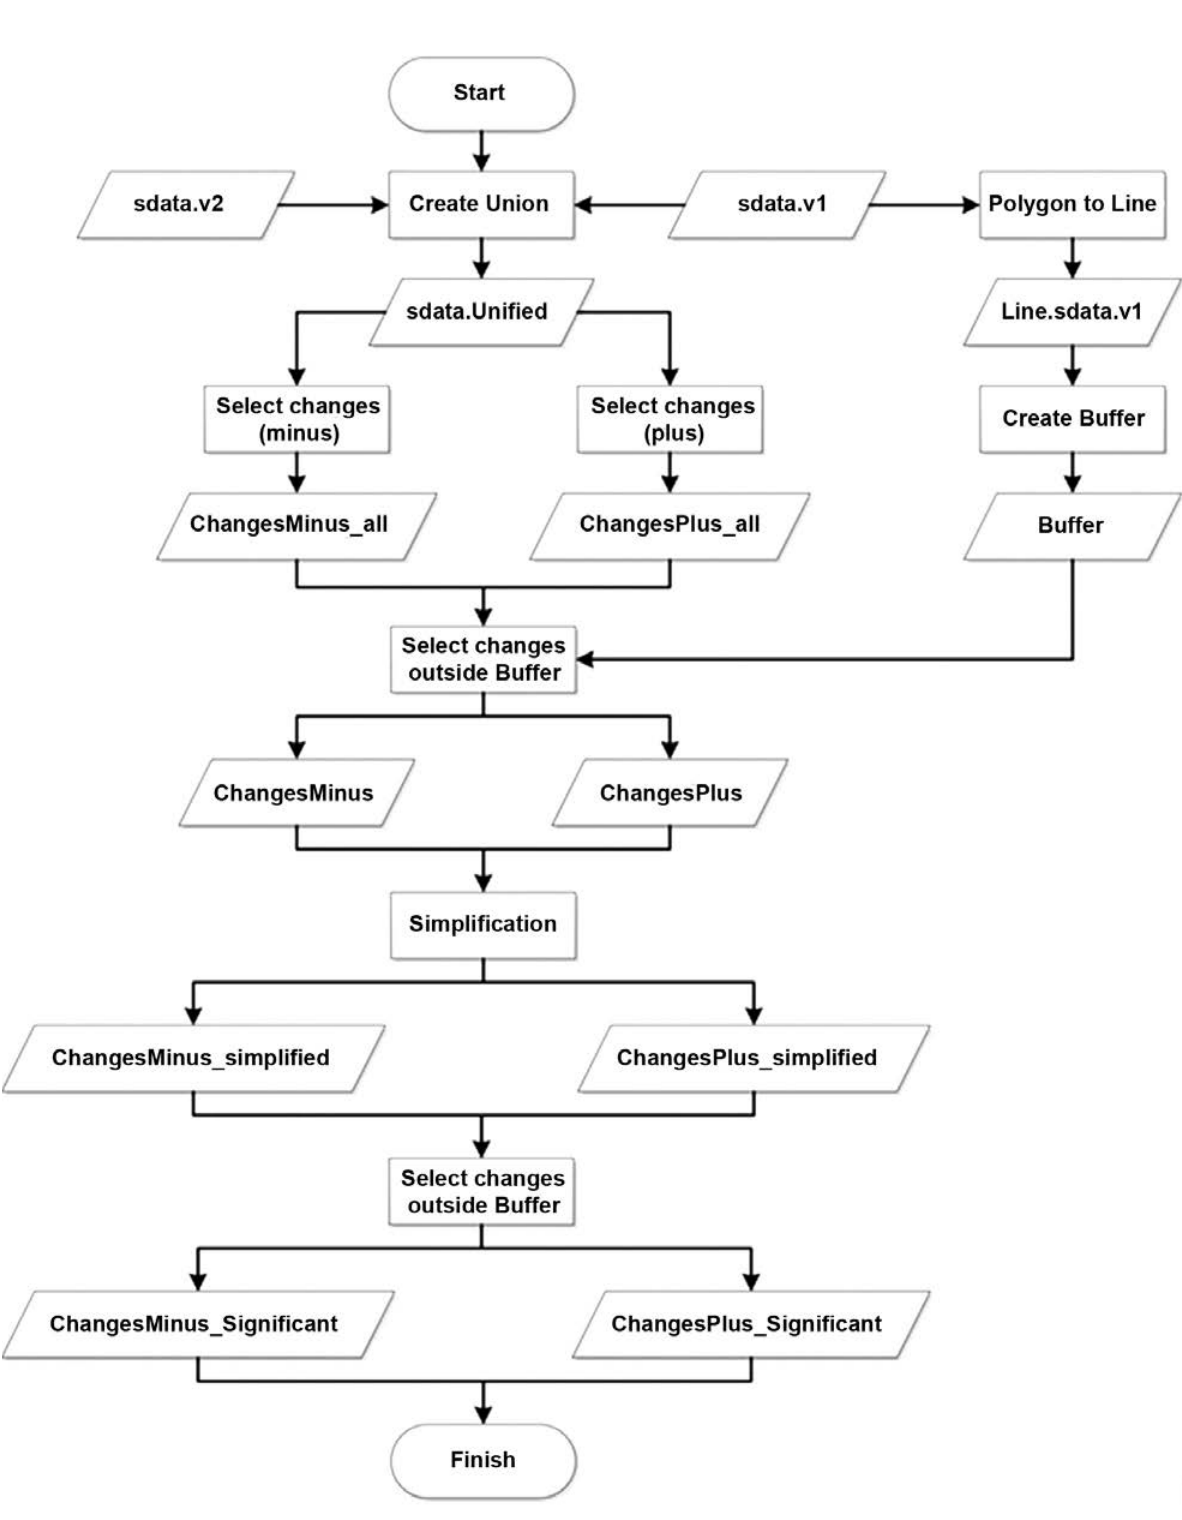
Fig. 8. Processes for determining significant changes in the features of land cover with a changed